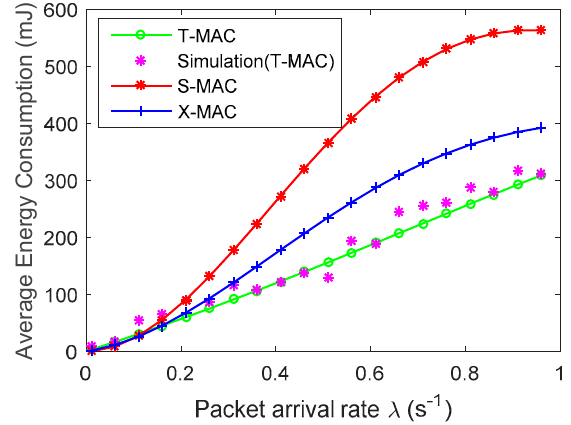
Figure 7. The average energy consumption versus packet arrival rate for the T-MAC, S-MAC and X-MAC protocols.